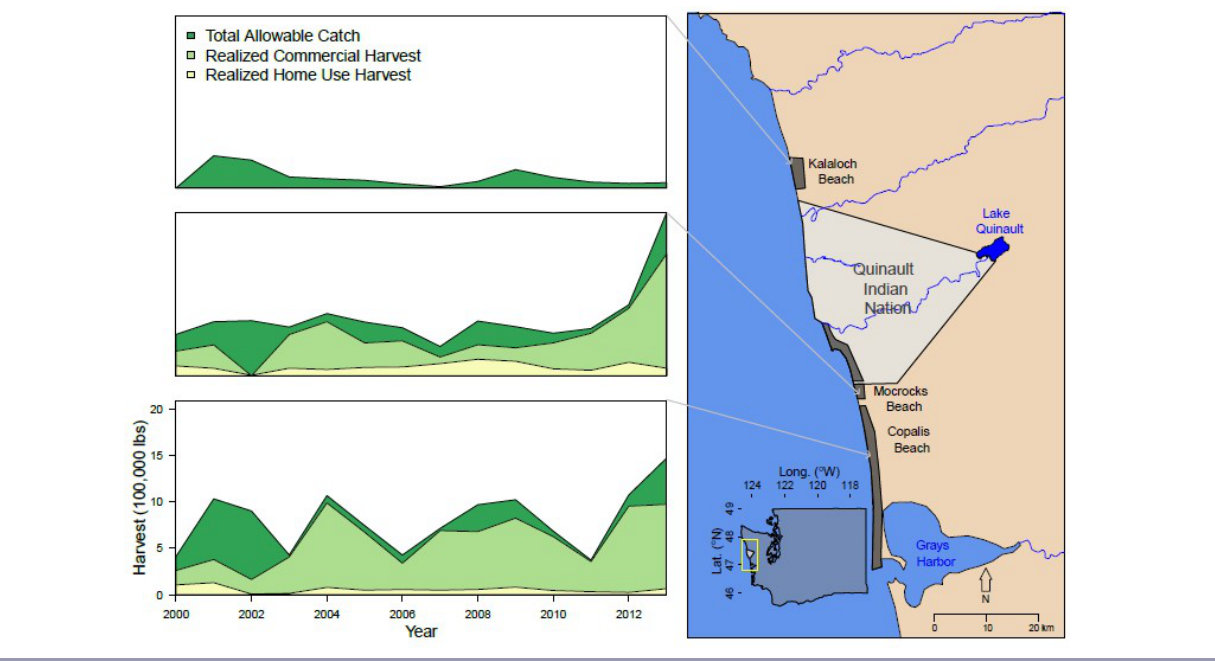
Fig. 1 . Map of the study region showing the Quinault Indian Nation’s reservation lands and primary razor clamming ( Siliqua patula ) beaches. The small insert on the map shows Washington State, USA; the study site is outlined in a yellow rectangle. Allowable and realized catches for three comanaged, off-reservation beaches are shown in the panels on the